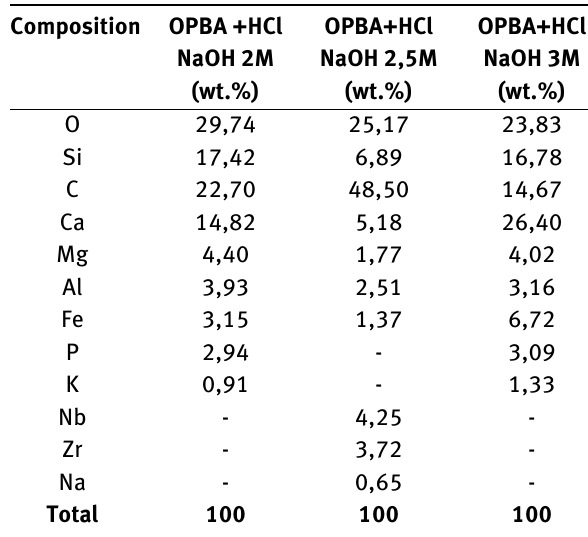
Table 2: The results of OPBA analysis with